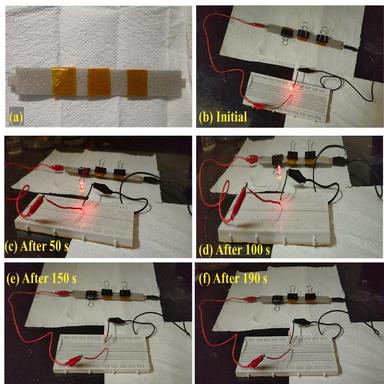
Photographs of (a) two supercapattery devices connected in series, (b–f) asymmetric supercapattery device BiOBr/g-C3N4||g-C3N4 powering a red LED. (For interpretation of the references to colour in this figure legend, the reader is referred to the web version of this article.)